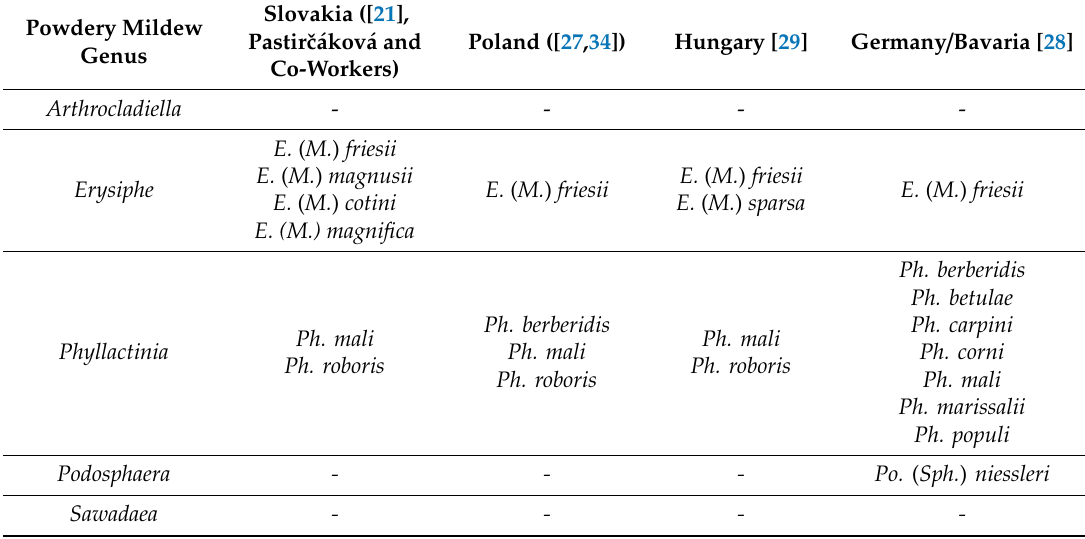
Table 3. Additional powdery mildews in neighbouring countries compared with Czech survey (this